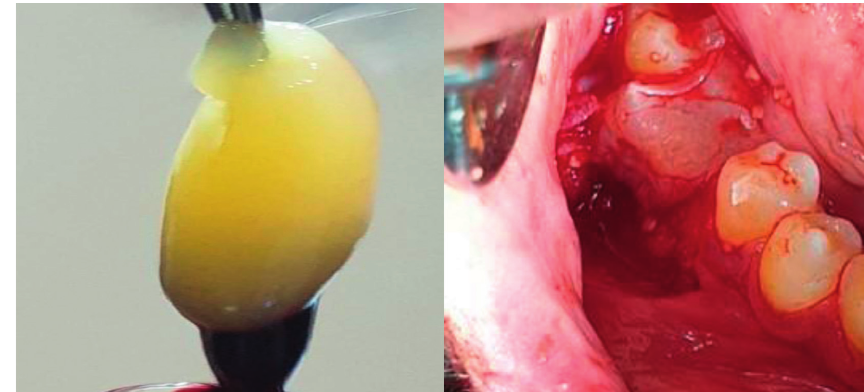
Figure 5: L-PRF was used to cover the graft materials.